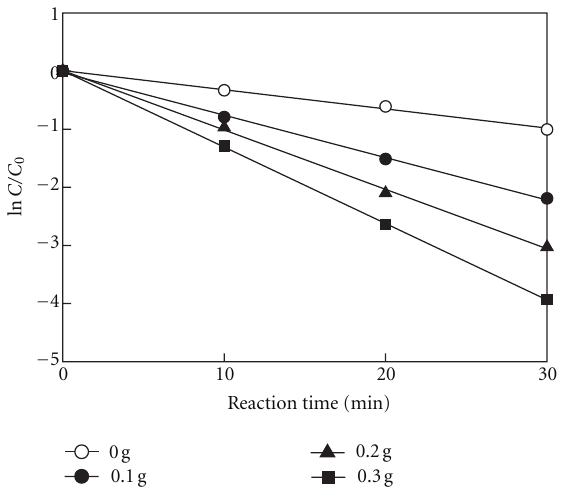
Figure 4: Degradation rate of methylene blue measured at various dissolved oxygen